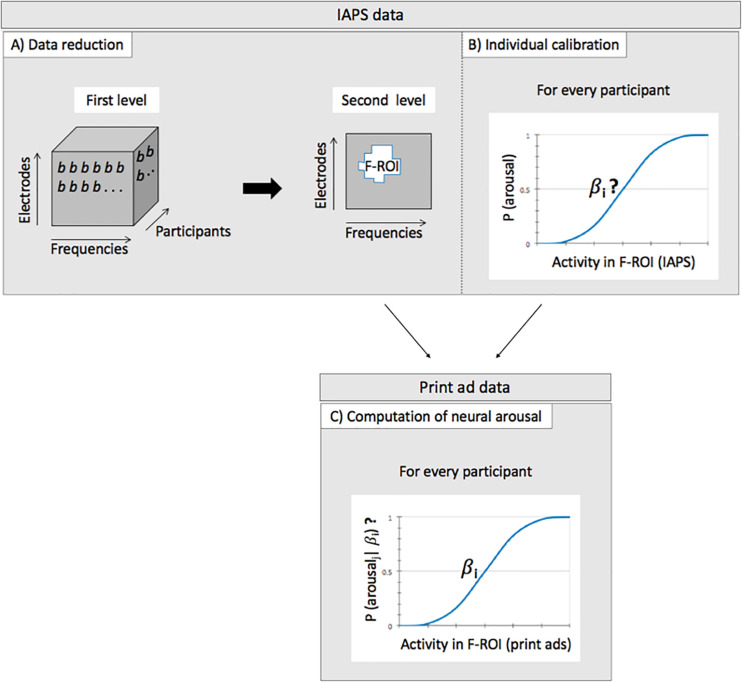
Schematic representation of the different steps of the analysis of assessing neural arousal per ad. Step (A) and step (B) are performed on the IAPS data, step (C) on the print ad data. (A) Data reduction by searching for how and where in the brain, the difference between low and high arousal is consistently represented in the EEG data across participants. This step results in an arousal Frequency by Region of Interest (F-ROI). (B) Individual calibration of the data as defined in panel (A), by searching for each participant for the optimal relation between the participants’ specific EEG response on the one hand (in the F-ROI) and the IAPS pictures on the other hand (DV = low vs high arousal; logistic regression). This step results in participant specific coefficients (indicated by βi) that link EEG activity and arousal level. (C) Computing for each participant i and print ad j, the probability that a print advertisement evokes neural arousal by selecting activity from the arousal F-ROI that is obtained while viewing the print ads (and given βi).